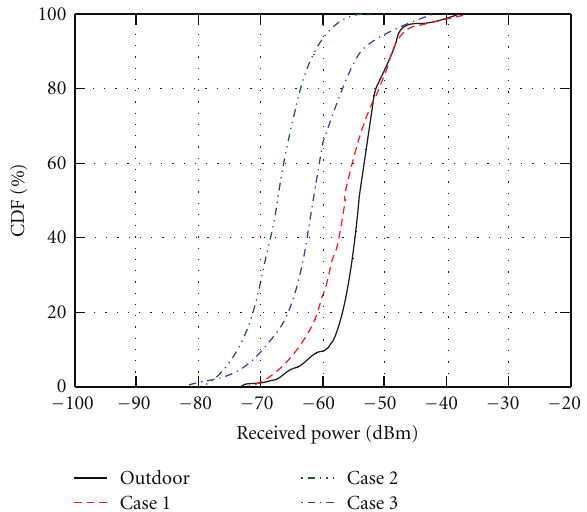
Figure 11: Received powers for desired signal and interference.